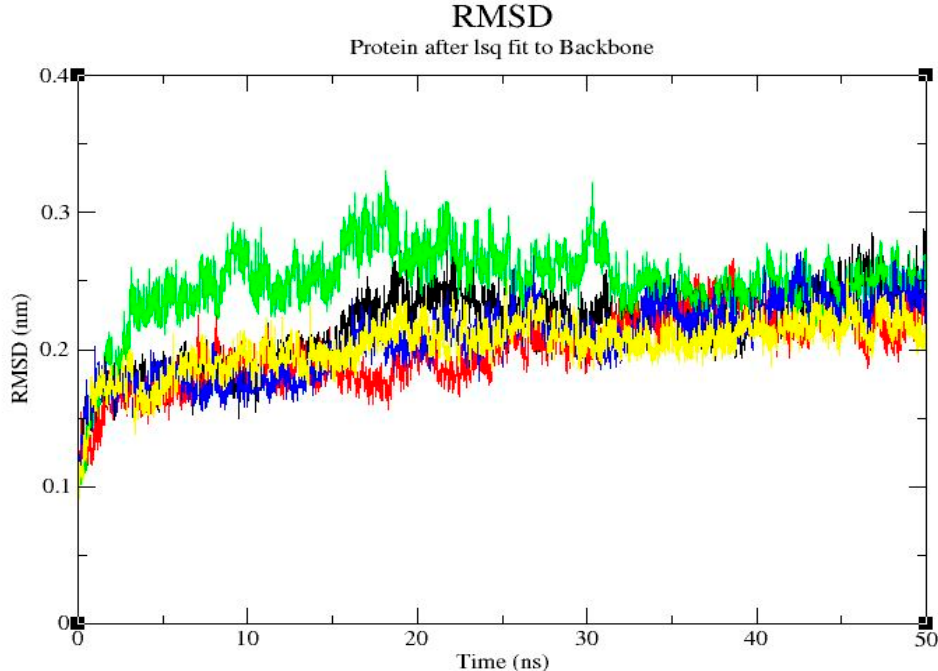
Figure 4. Molecular Dynamics (MD) simulation of NDM-1 with compound ( 3 ) and its structural analogues ( 5c , 5g-i ) over 50 ns. RMSD trajectory of NDM1- 3 complex (black color). RMSD trajectory of NDM1- 5c complex (red color). RMSD trajectory of NDM1- 5g complex (blue color). RMSD trajectory of NDM1- 5h complex (green color). RMSD trajectory of NDM1- 5i complex (yellow color).